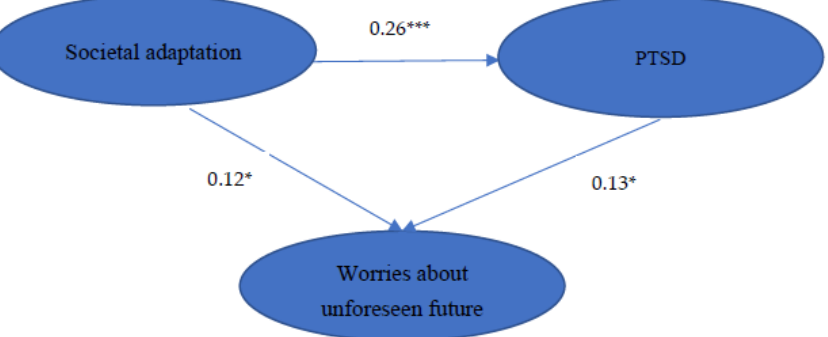
Figure 2. The conceptual model showing interrelationships between societal adaptation, PTSD and vaccine worries. *: p < 0.05; ***: p < 0.001. PTSD, post-traumatic stress